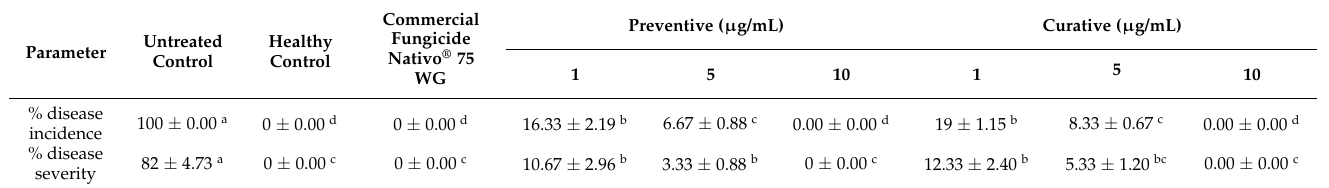
Table 2. Effect of antimycin A in suppression of wheat blast disease development in artificially inoculated wheat seedlings. Means ± standard errors having a common letter are not significantly different at the 5% level of